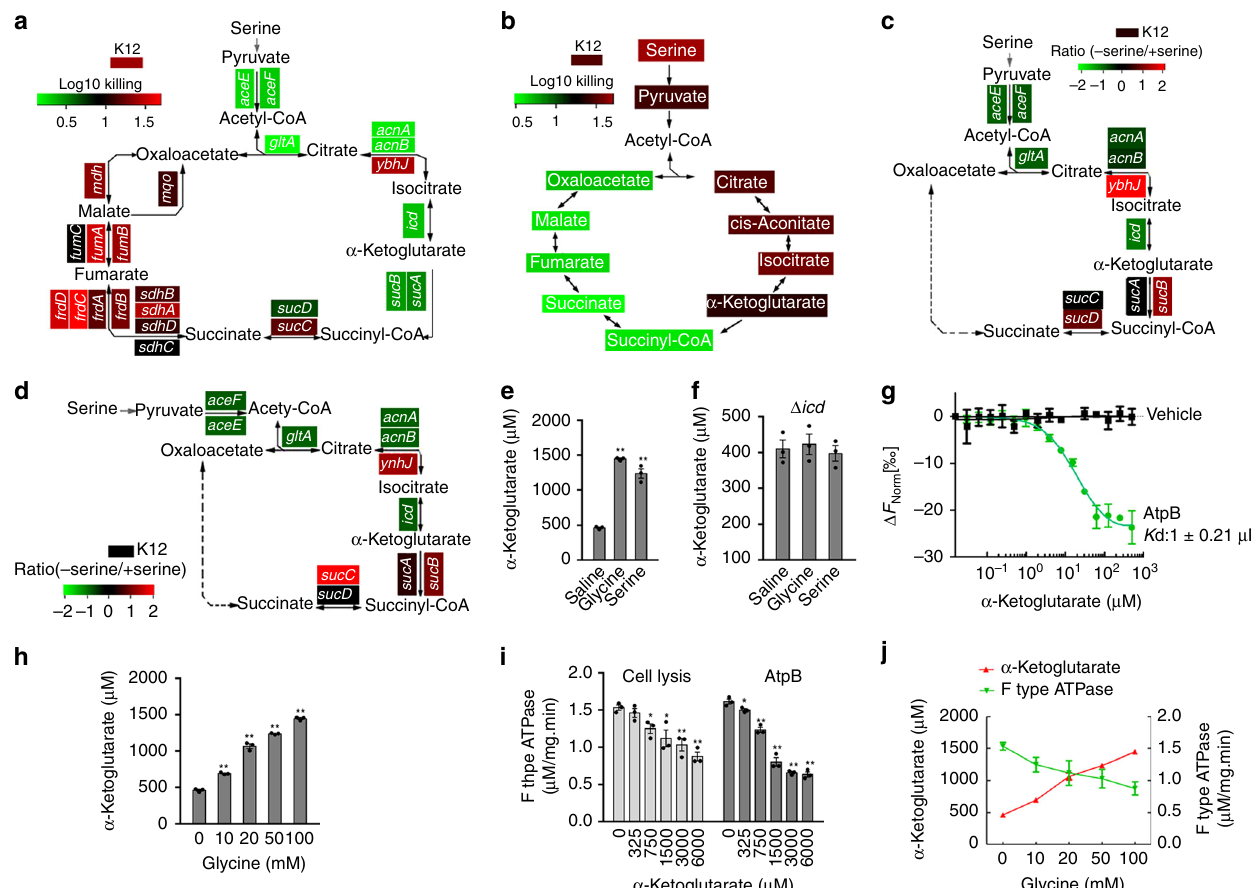
Fig. 5 The TCA cycle regulates bacterial serum susceptibility. a Summary of relative survival of the indicated mutant strains of E. coli K12 in the presence or absence of 50 mM serine plus 100 µ L serum for 2 h ( n = 3). b Summary of relative survival of E. coli K12 in the presence or absence of the indicated metabolites of the TCA cycle plus 100 µ L serum for 2 h ( n = 3). c , d Summary of relative ATP synthase activity ( c ) and ATP content ( d ) of the indicated mutant strains of E. coli K12 for 2 h in the presence and absence of 50 mM serine plus 100 μ L serum. Heat map scale ( a – d ) (green to red) represents low to high killing ( a , b ) or ratio ( c , d ) without the indicated genes ( a, c and d ) or with the indicated metabolites ( b ) ( n = 3). e , f Intracellular α -Ketoglutarate concentration in the presence or absence of 100 mM glycine or serine ( e ), and the effect of loss of icd ( f ) ( n = 3). g AtpB and α -Ketoglutarate interaction assay by MST ( n = 3). h Effect of exogenous glycine (0 – 100 mM) on the intracellular α -Ketoglutarate level ( n = 3). i Measurement of intracellular